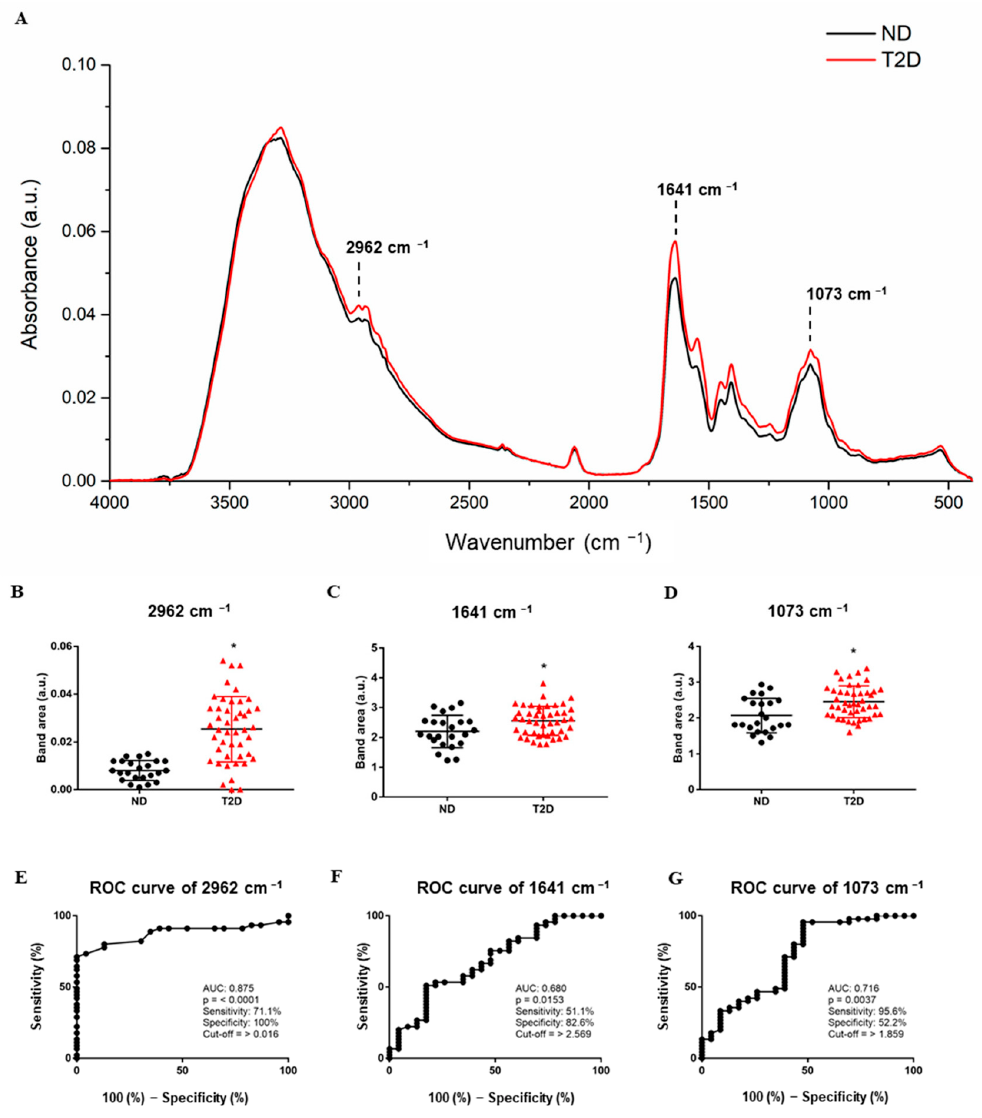
Figure 2. Representative average ATR-FTIR spectra (4000–400 cm − 1 ) in saliva of non-diabetic subjects (ND) and uncontrolled type 2 diabetic patients (T2D) ( A ). Band area of 2962 cm − 1 ( B ), 1641 cm − 1 ( C ), and 1073 cm − 1 ( D ). ROC curve analyses of 2962 cm − 1 ( E ), 1641 cm − 1 ( F ), and 1073 cm − 1 ( G ). * Significantly different compared to ND.